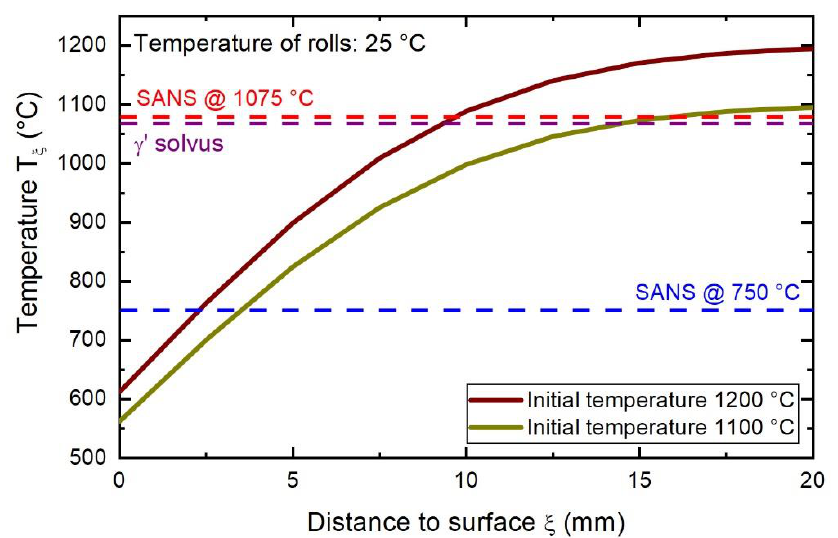
Figure 8. Calculated temperature profile of the bar during hot rolling and contact of the bar with the roll after 1 s of contact. The assumed temperature of the roll is 25 °C. The γ′ solvus temperature as well as the temperatures at which the SANS measurements were conducted are indicated by the dashed lines.